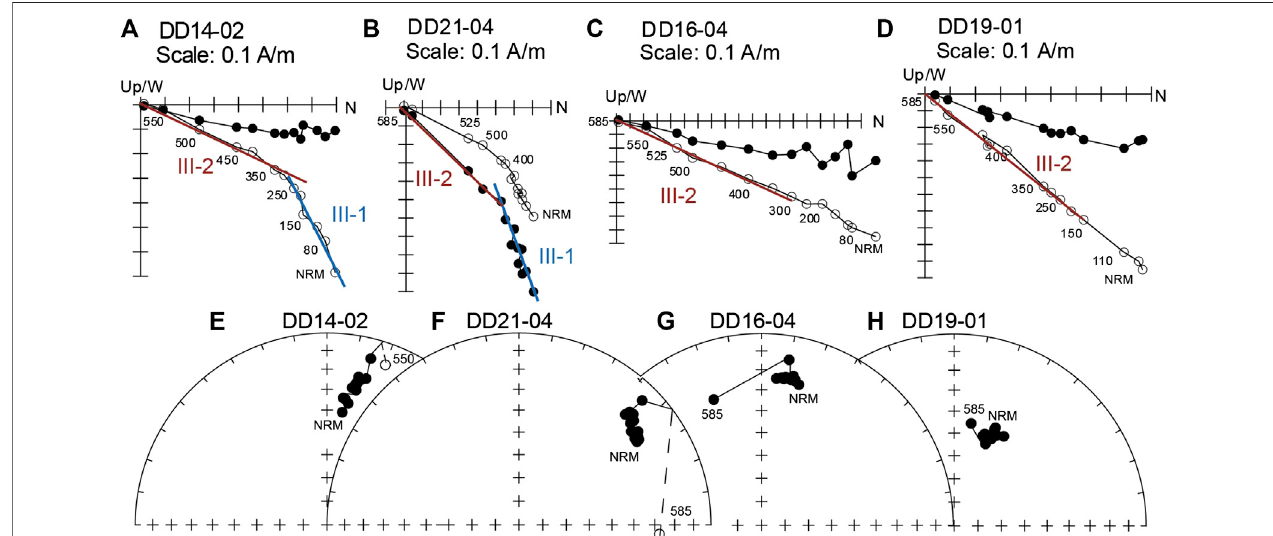
FIGURE 5 | (A – D) Representative orthogonal plots (Zijderveld, 1967) of stepwise thermal demagnetization behavior of Emeishan basalt unit III. Open (solid) circles representprojectionsontovertical(horizontal)plane (E – H) Equal-areaprojectionsofthethermaldemagnetizationdirections.Open(solid)circlesrepresentlower (upper) hemisphere projection. The numbers indicate the thermal demagnetization levels in ° C.